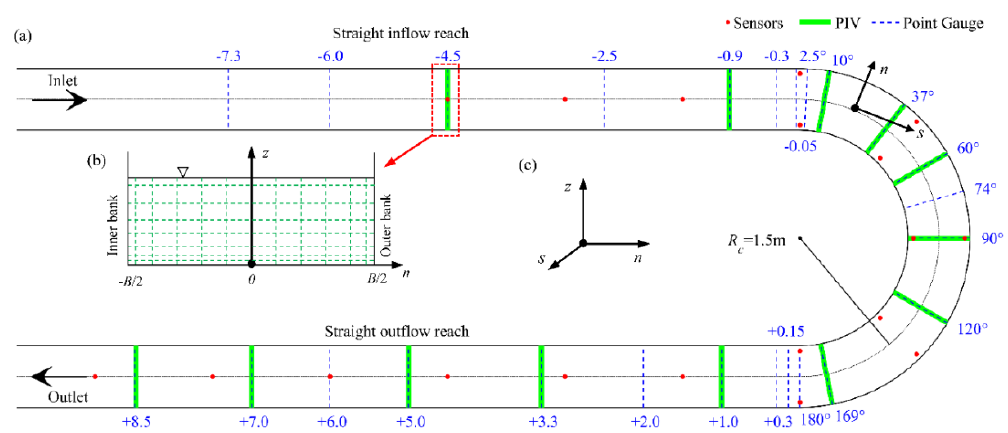
Figure 1. ( a ) Plan of the U-shaped flume with indication of positions of measurements; ( b ) Measuring grids of PIV (Particle Image Velocimetry) system (11 vertical lines and 7 horizontal lines); ( c ) the definition of the coordinate system: stream-wise (s), span-wise (n), and vertical (z).